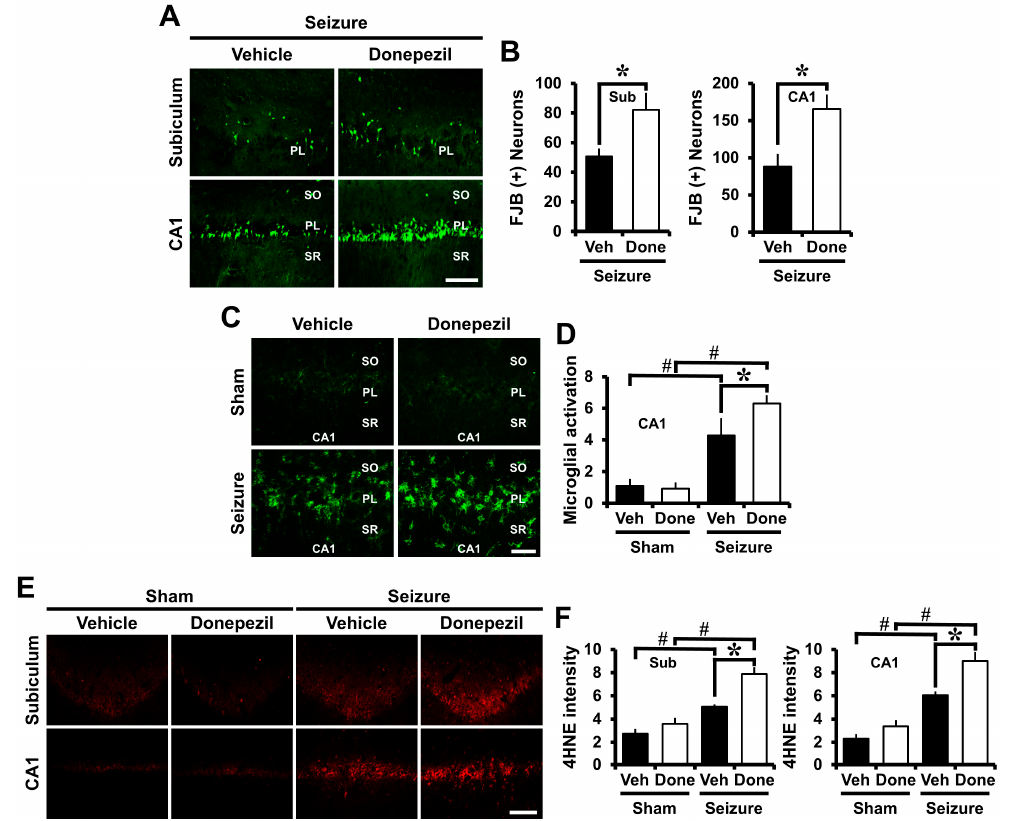
Figure 1. Pre-treatment of donepezil increased seizure-induced neuronal death, microglia activation and oxidative injury. ( A ) Representative images show the fluoro-jade B (FJB) (+) neurons in the CA1 and subiculum (Sub) of the hippocampus. The number of degenerating neurons was increased in the donepezil-treated group when compared to the vehicle-treated group. Scale bar = 100 µ m; ( B ) The bar graph shows the number of degenerating neurons; ( C ) Fluorescent images indicate microglia activation in the CA1 of the hippocampus. In the group treated with donepezil after seizure, microglia activation was increased when compared to seizure vehicle group. Scale bar = 50 µ m; ( D ) The bar graph was obtained by scoring the activation of microglia; ( E ) Fluorescent images indicate the 4HNE intensity in the CA1 and subiculum of the hippocampus. Oxidative injury increased in the donepezil group when compared to the vehicle group. Scale bar = 100 µ m; ( F ) The bar graph shows the quantified 4HNE intensity. Data are mean ± S.E.M., n = 6 from each sham group. n = 5–7 from each seizure group. * Significantly different from vehicle-treated group. * ,# p < 0.05. SO (Stratum Oriense), PL (Pyramidal Layer), SR (Stratum Radiatum).